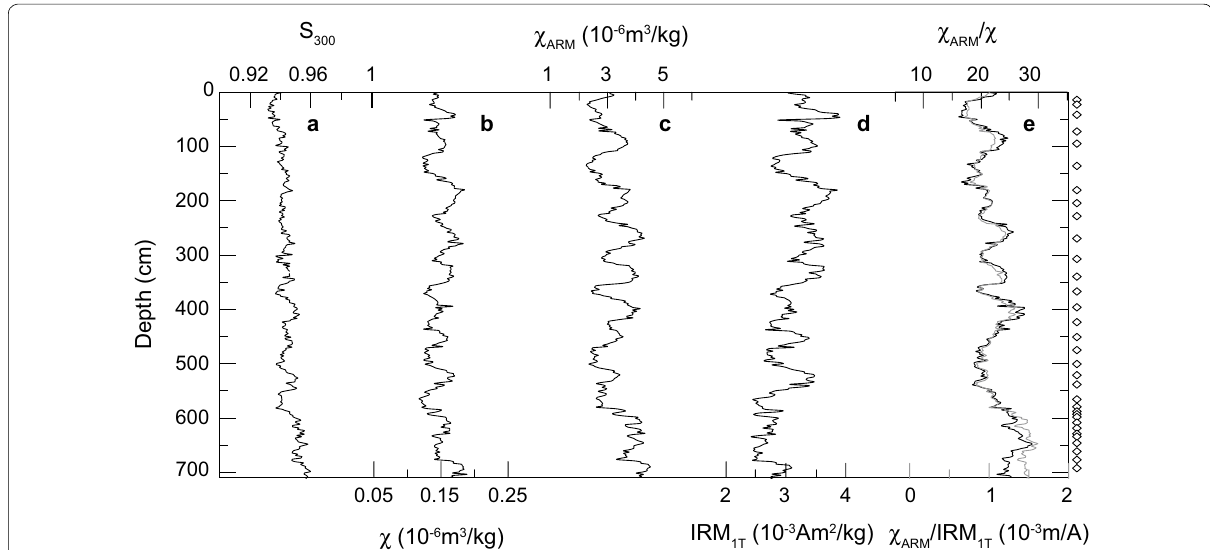
Fig. 5 Down-core variations in rock magnetic parameters. a S -ratio (S 300 ), b magnetic susceptibility ( χ ), c susceptibility of anhysteretic remanent magnetization ( χ ARM ), d isothermal remanent magnetization acquired in a DC field of 1 T (IRM 1T ), and e grain-size parameters ( χ ARM / χ and χ ARM /IRM 1T ). Selected depths for the hysteresis measurements are marked as open diamonds on the right of the